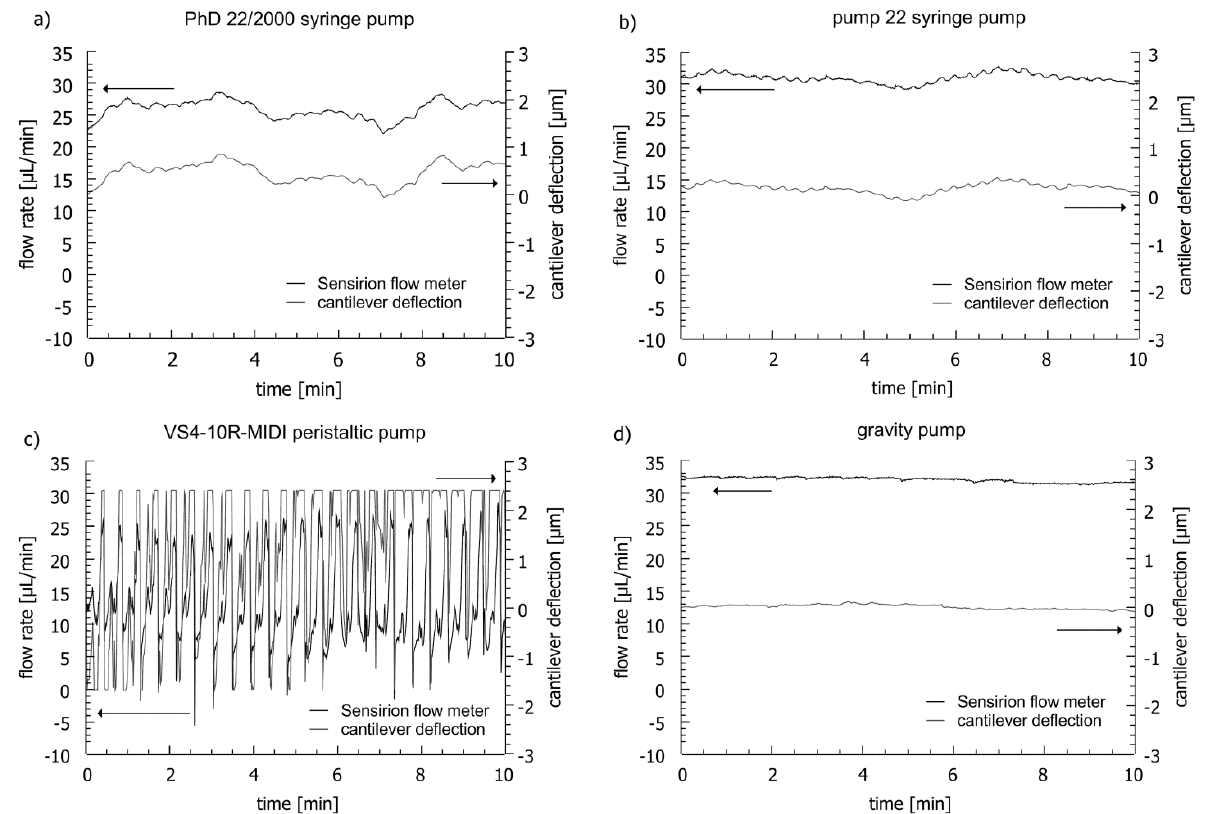
Figure 10. Flow stability measurement with the 11.2 µm thick SU-8 flow sensor with 180 holes of 10 × 10 µm 2 and the thermal flow meter from Sensirion with four different pumps.